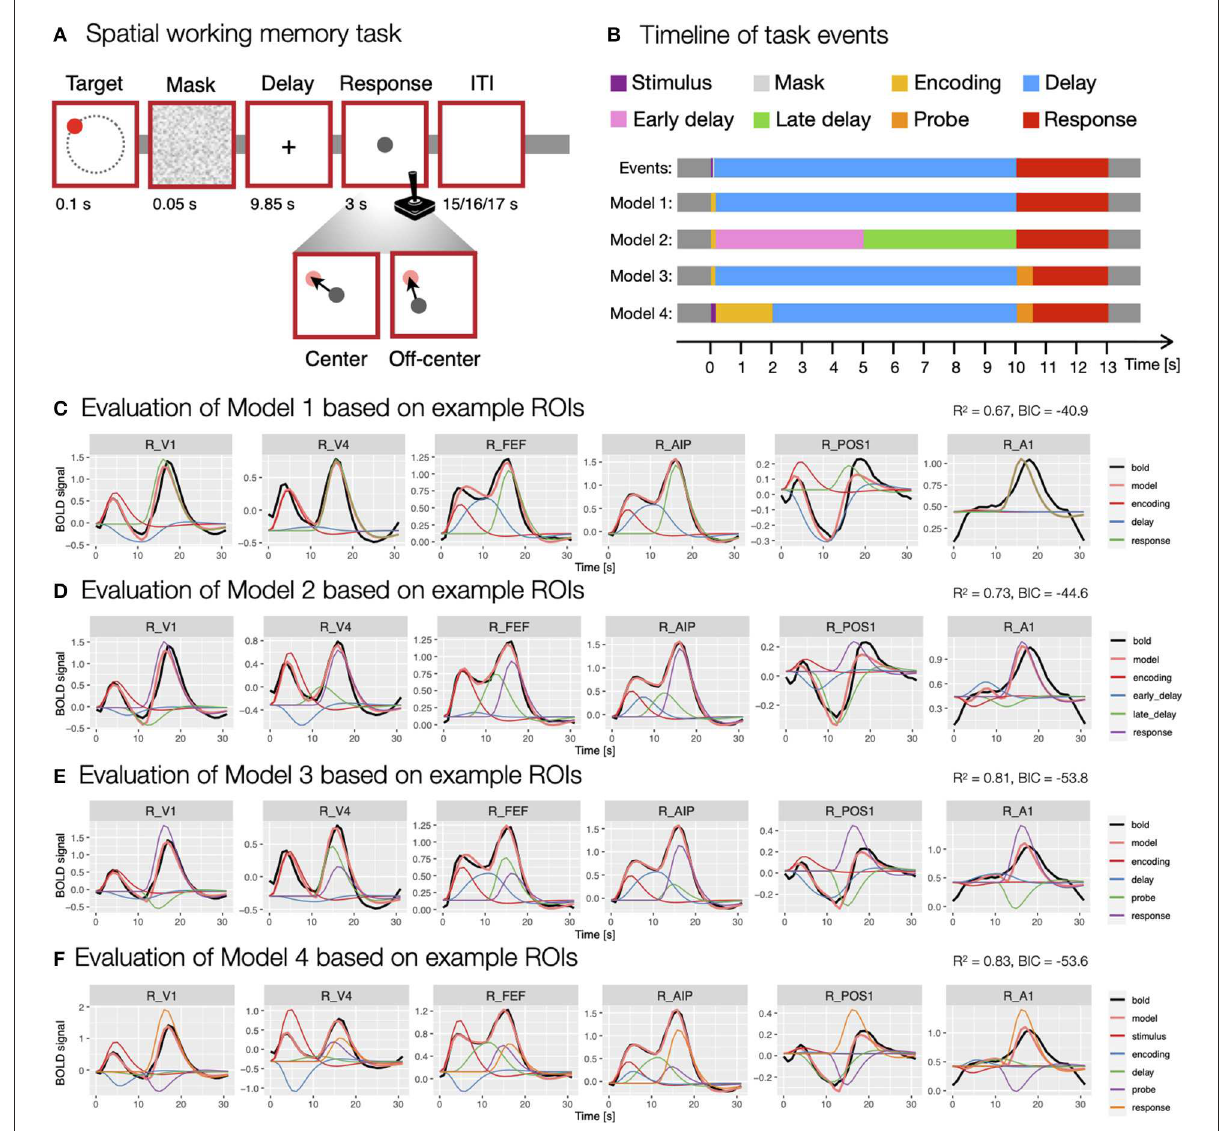
FIGURE3 Modeling of the spatial working memory task trial using different event models. (A) The design of the spatial working memory task. Participants were asked to remember the position of a briefly presented target stimulus and, after a delay period, to give a response by moving a probe using a joystick to the previously remembered target position either from the center of the screen ( center condition) or a random off-center position ( off-center condition). (B) The timing and duration of different assumed events in the task, which were aligned to TR = 1 s used in the fMRI recording. (C–F) The evaluation of specific models. The models were evaluated using the evaluate_model function with double-gamma HRF based on the average activity during a task trial for individual ROIs. The individual plots were prepared using the plot_model based on the activity in six example ROIs (i.e., R_V1, right primary visual cortex; R_V4, right fourth visual area; R_FEF, right frontal eye fields; R_AIP, right anterior intraparietal area; R_POS1, right parieto-occipital sulcus area 1; R_A1, right primary auditory cortex; Glasser et al., 2016) that differed in BOLD responses during a spatial working memory task. The black line shows the average BOLD response, the pink line the modeled BOLD response and the thin colored lines depict individual responses to specific events. The reported R 2 and BIC represent mean values across all 360 ROIs in the HCP-MMP1.0 parcellation (Glasser et al.,